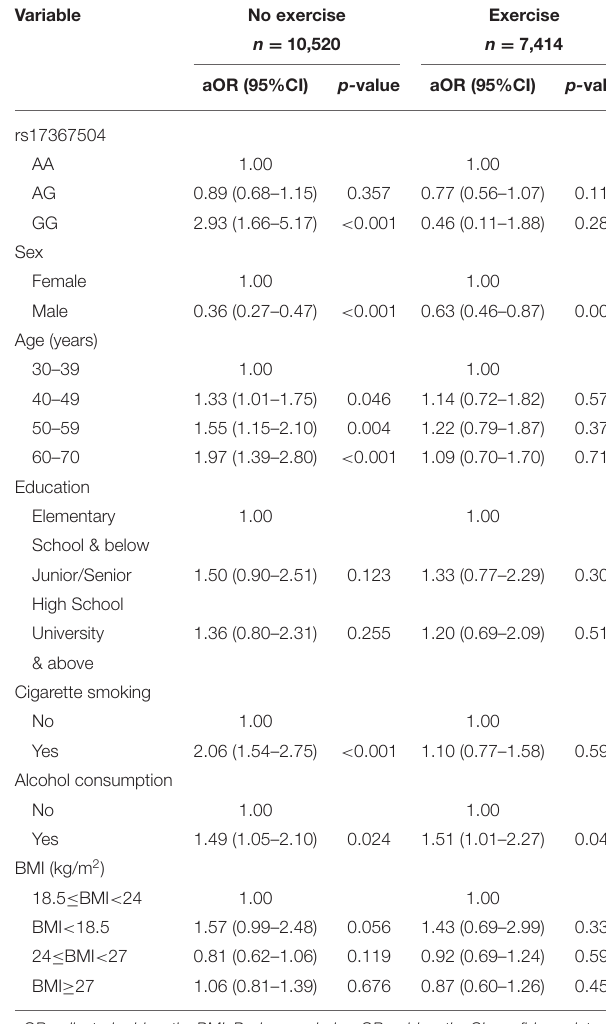
TABLE 2 | Association between MDD and study variables. Variables